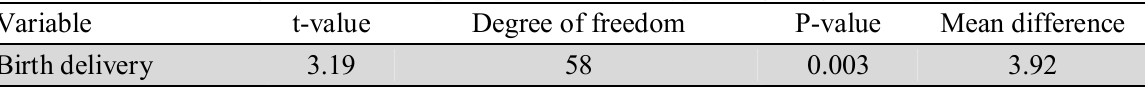
The results of surveying the relationship between different types of giving birth and depression